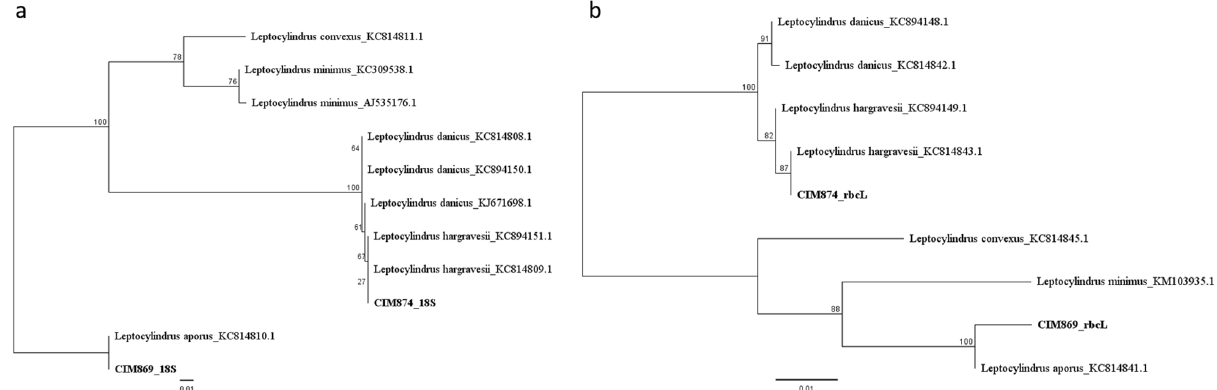
Figure 2. Leptocylindrus barcodes 18S ( a ) and rbcL ( b ) phylogenetic reconstruction with CIM cultures and GenBank sequences. For each GenBank sequence species and accession number are indicated. CIM culture sequences are marked in bold. Bootstrap values are indicated next to tree nodes.